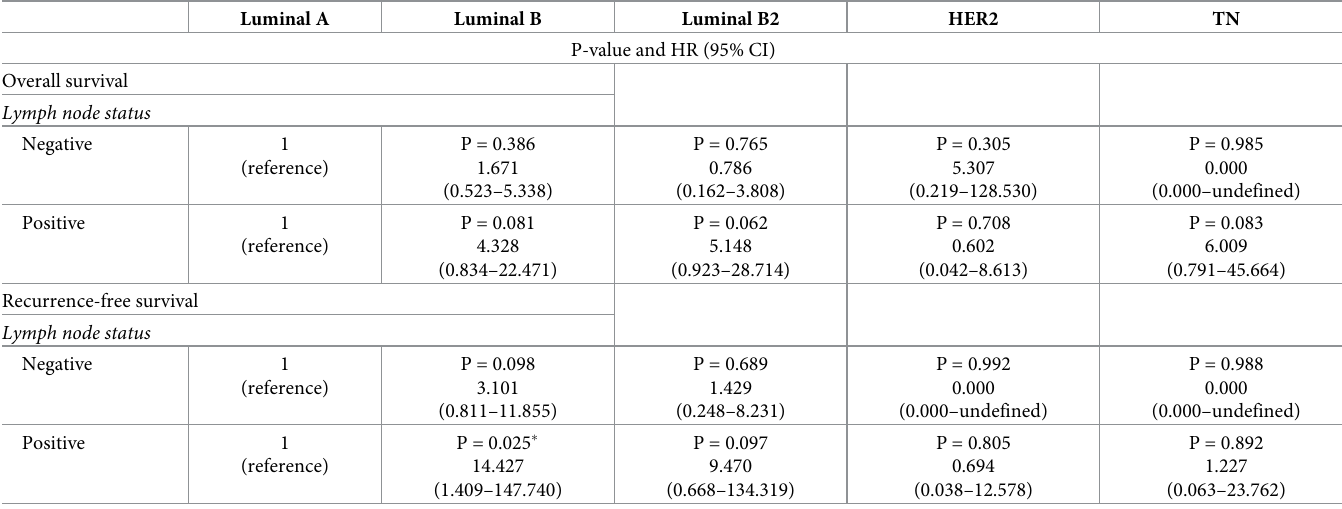
Table 3. Survival outcomes according to lymph node status and breast cancer